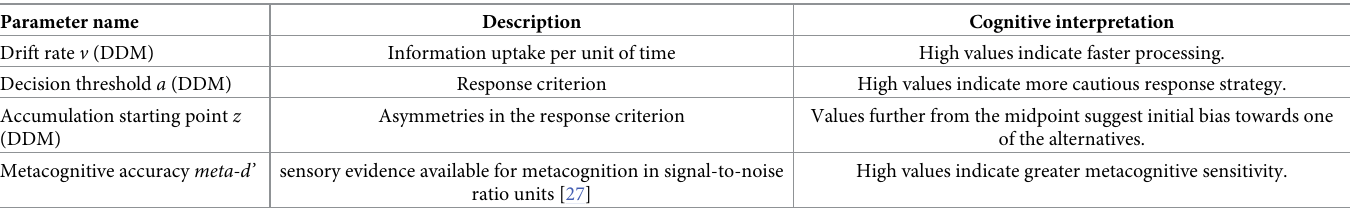
Table 1. Model-based parameters of interest derived from the Drift Diffusion Model [42] and meta-d’ [27].